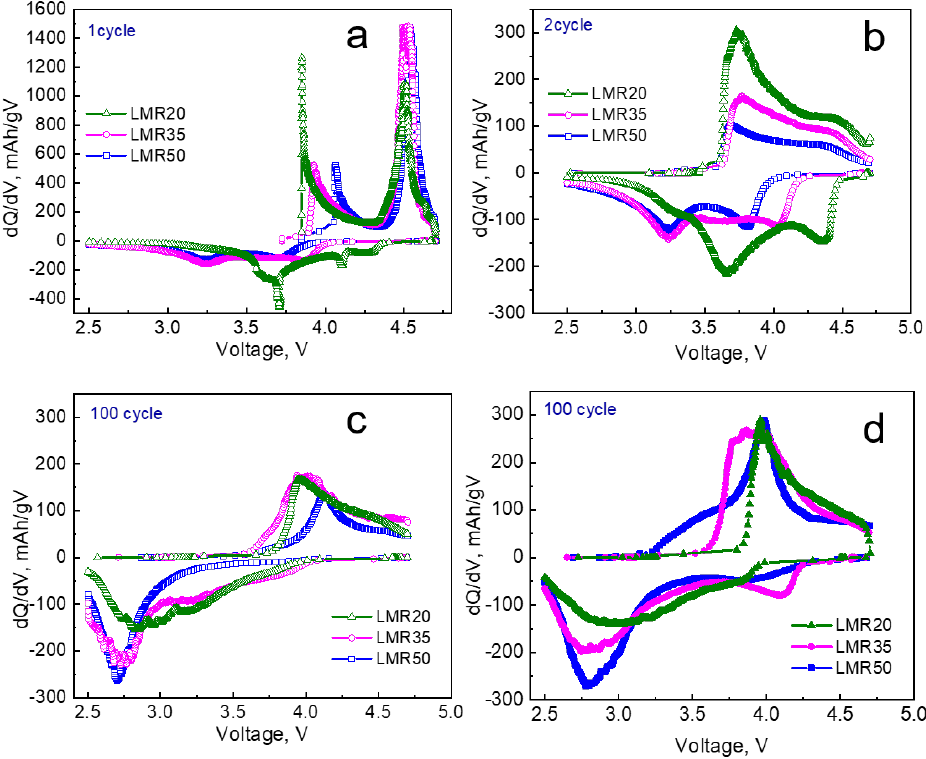
Figure 6. dQ/dV curves for the samples cycled ( a – c ) without formation and ( d ) by protocol 1 at the current density of 80 mA/g.